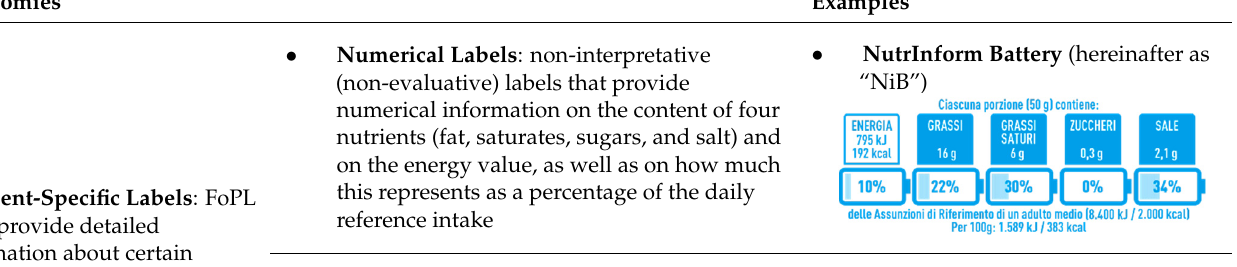
Table 1. Adapted EU Taxonomy and an example of front-of-pack labels (EU Commission, 2021).